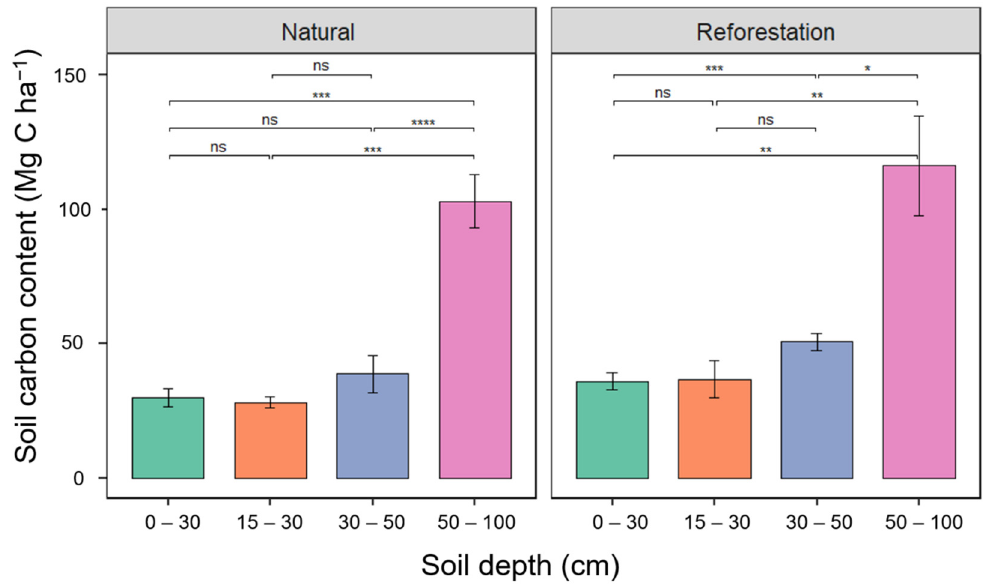
Figure 9. Average soil carbon content at varying soil depths from 0 to 100 cm at the natural and reforestation sites. Significant differences were denoted by * which indicates significance level at p < 0.01–0.05, ** at p < 0.01–0.001, *** at p < 0.001–0.0001, and **** at p < 0.0001while ns means no significant difference.